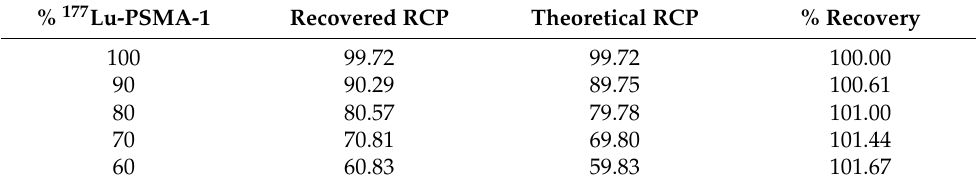
Table 3. Accuracy with % recovery in HPLC.